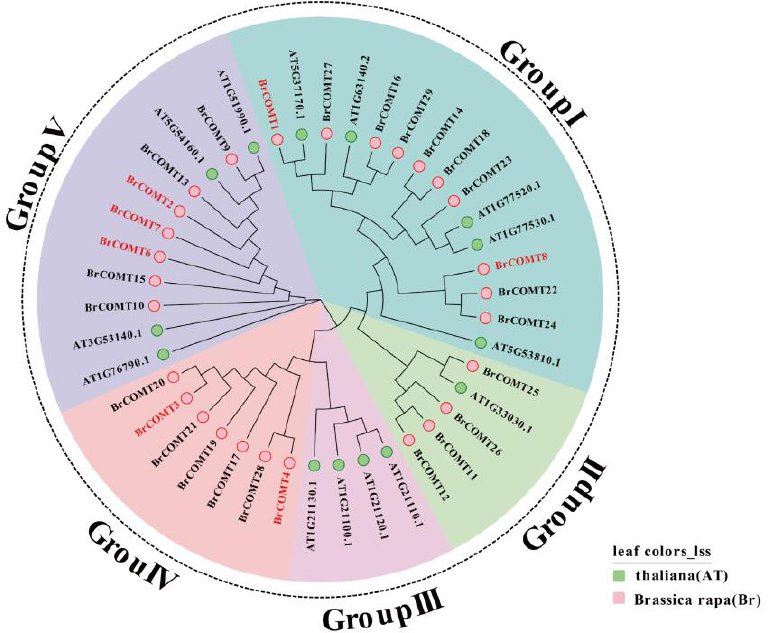
Figure 8. Phylogenetic analysis of 14 and 29 COMT protein sequences from A. thaliana and Chinese cabbage,